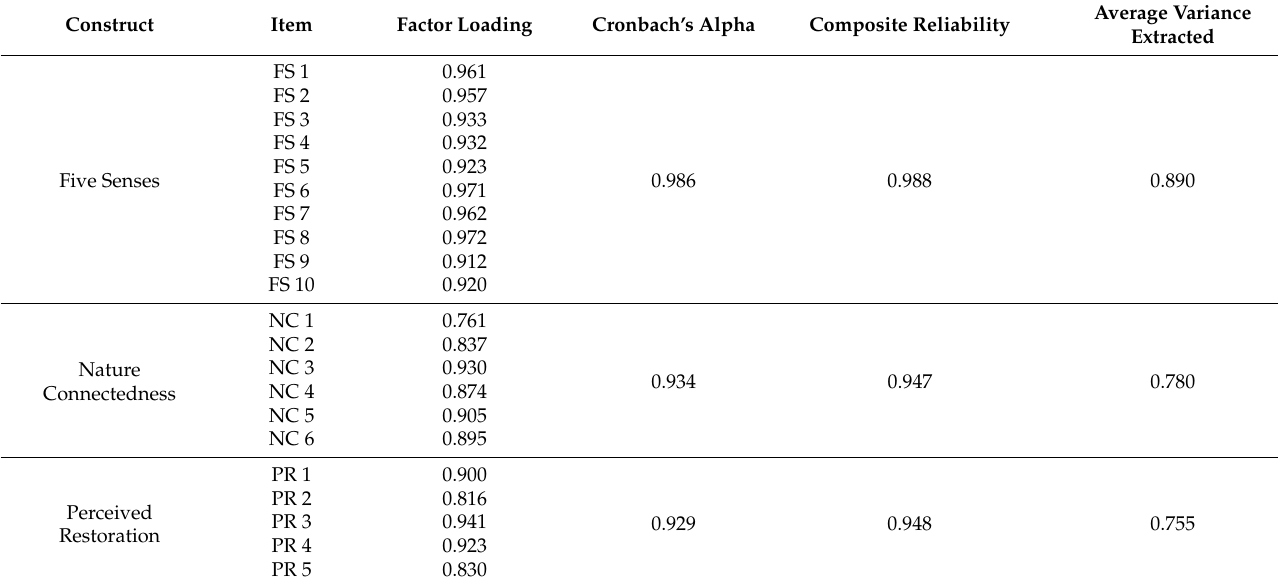
Table 1. Measurement statistics of the construct scales.